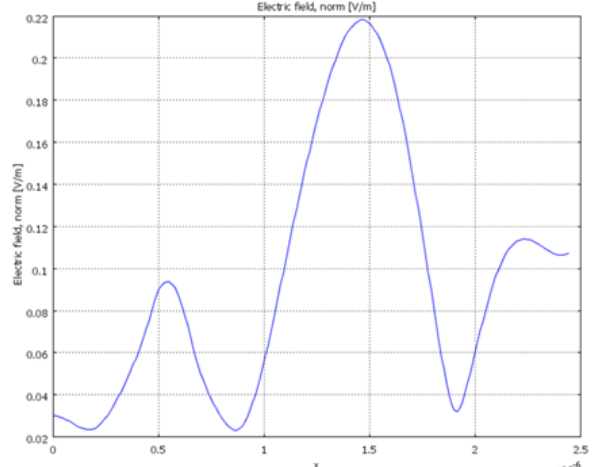
Figure7: Normalized electric field for our proposed structures